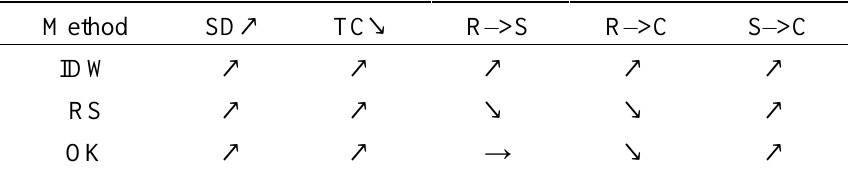
Table 11. The variation tendency of the interpolation